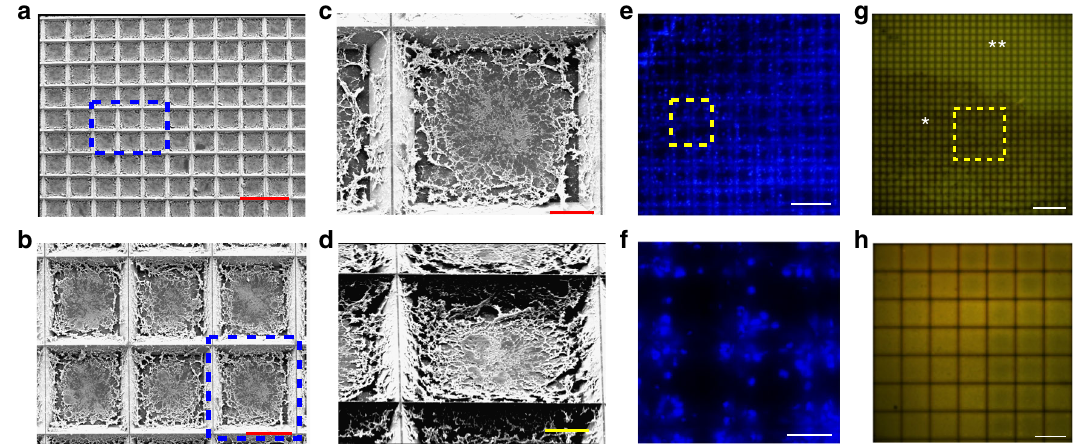
Fig. 3 Tissue pixelation and Bulk picoliter reagent loading characterization. a – d SEM characterization after tissue pixelation. Tissue partitioning and division into small pixels can be clearly visualized as tissue is seen inside the wells. The blue box in a is shown in b and the blue box in b is shown in c , d (scale bar: a 200 µ m; b 50 µ m; c , d 20 µ m). e , f DAPI- fl uorescence imaging of the same pixelated tissue showing nuclei inside the well boundaries. f shows the region